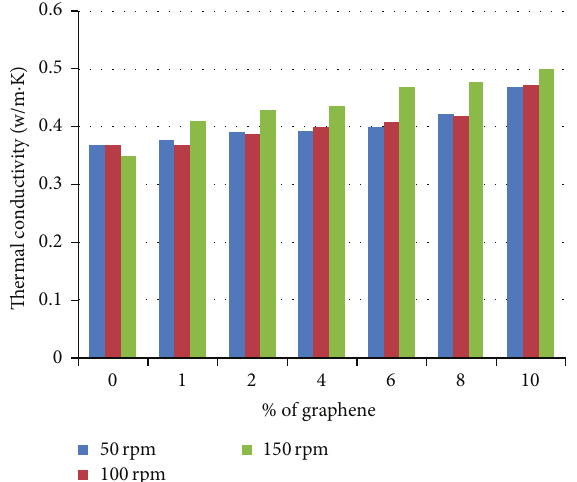
Figure 3: Effect of % of graphene on thermal conductivity of LLDPE/C-GNPs composites at different screw/feeder